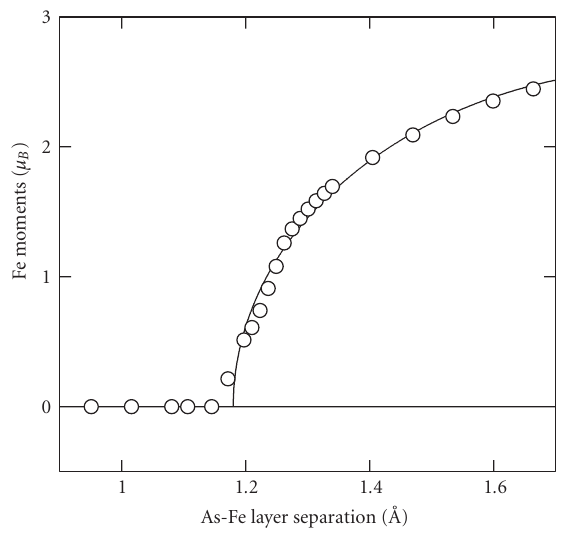
Figure 1: The magnetic moment, M , as a function of the Fe-As layer separation, z , calculated for Ba(Fe 0 . 92 Co 0 . 08 ) a fit by (3).